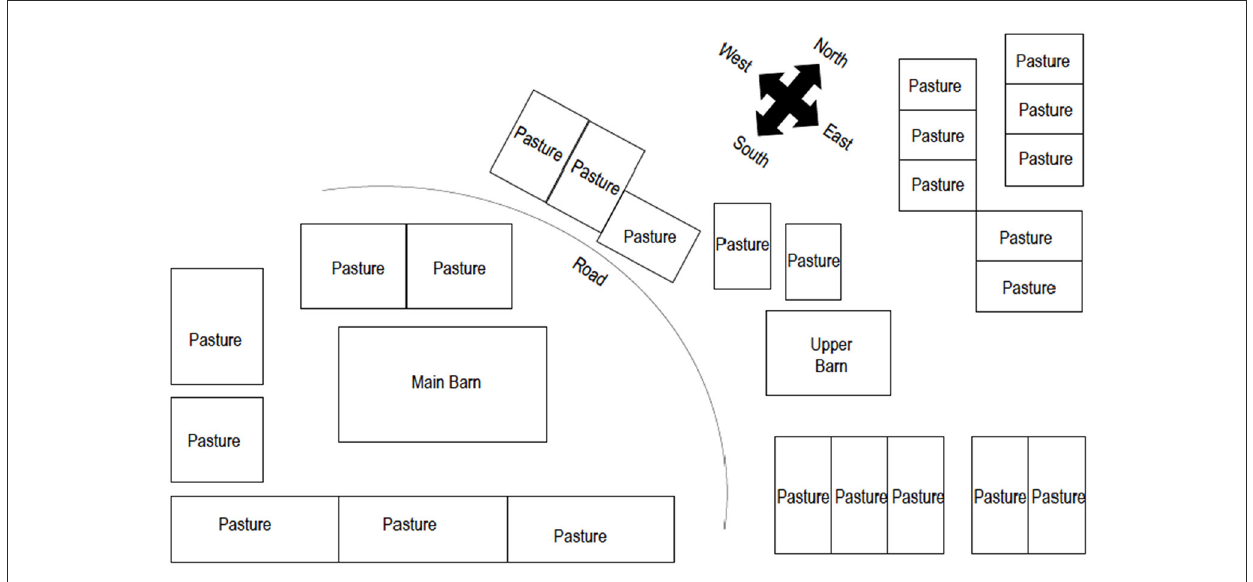
FIGURE1 Map of farm. Drawing courtesy of Spencer